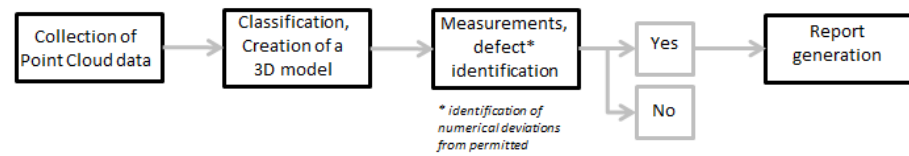
Figure 18. Workflow of geometrical parameter measurements.